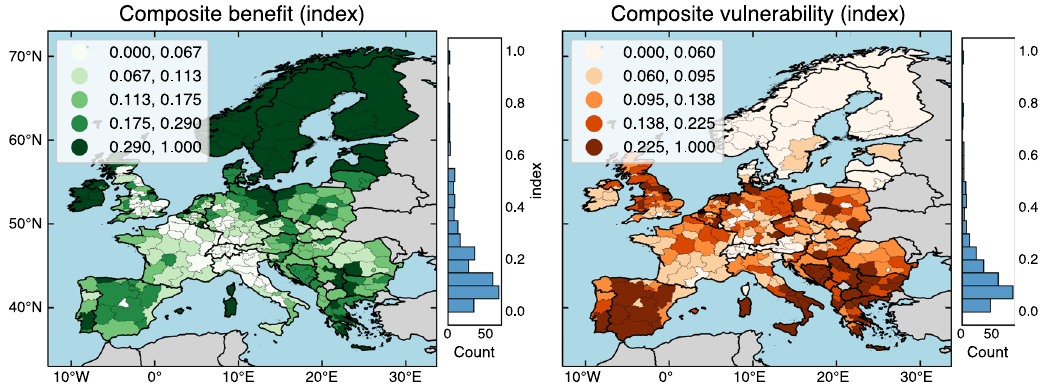
Fig.5|Mapsofcompositeindicesofelectricitysectorbene fi tandvulnerability. Composite indices combine fi ndings on all six impact types across 248 MGA sce- nariosand the minimum cost scenarioascompared to the frozen scenario of 2035 (details are provided in Methods). Composite bene fi t and vulnerability indices range from 0 (low) to 1 (high). These two composite indices are treated separately because various bene fi ts and vulnerabilities do not necessarily compensate each other, for example, due to differences in required skill sets of employment